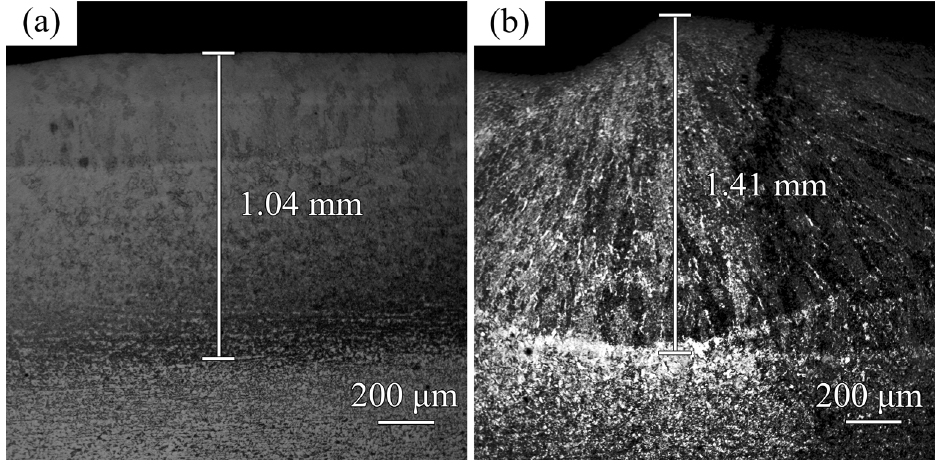
Figure 3. Macrostructure morphology of the LSM process-treated samples: ( a ) sample 1 and ( b ) sample 2.